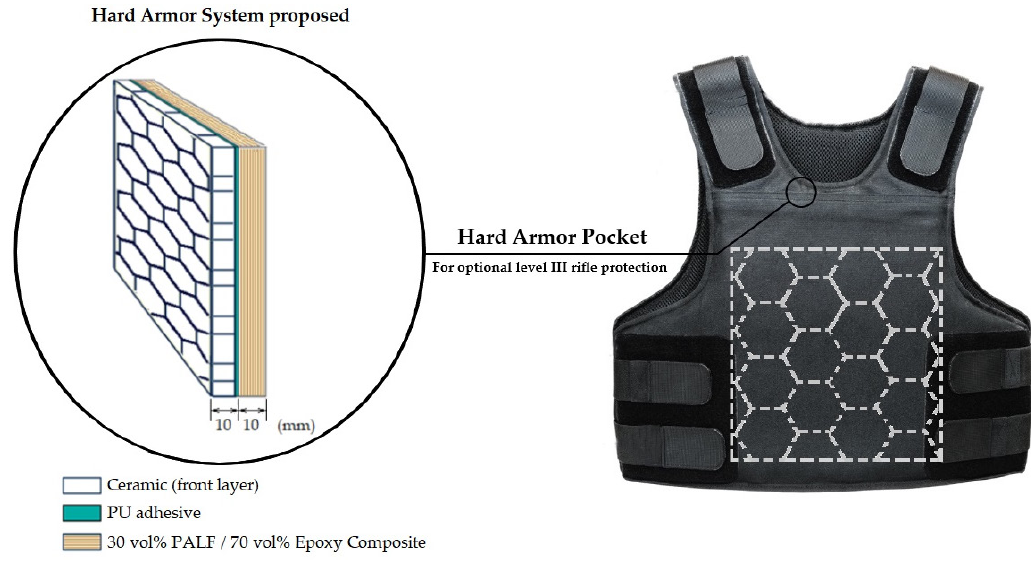
Figure 1. A schematic of the hard armor system proposed and its accommodation in a conventional bulletproof vest (Illustration done by the authors).